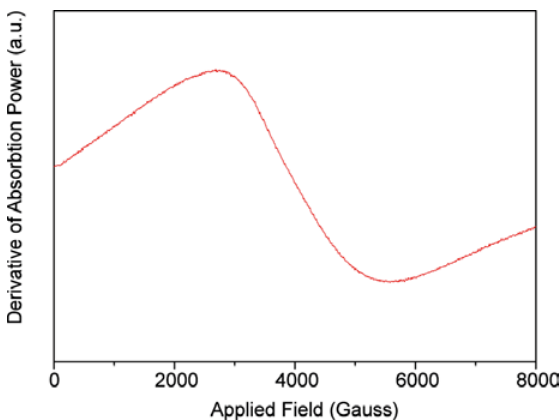
Figure 4. ESR absorption spectrum of Mn